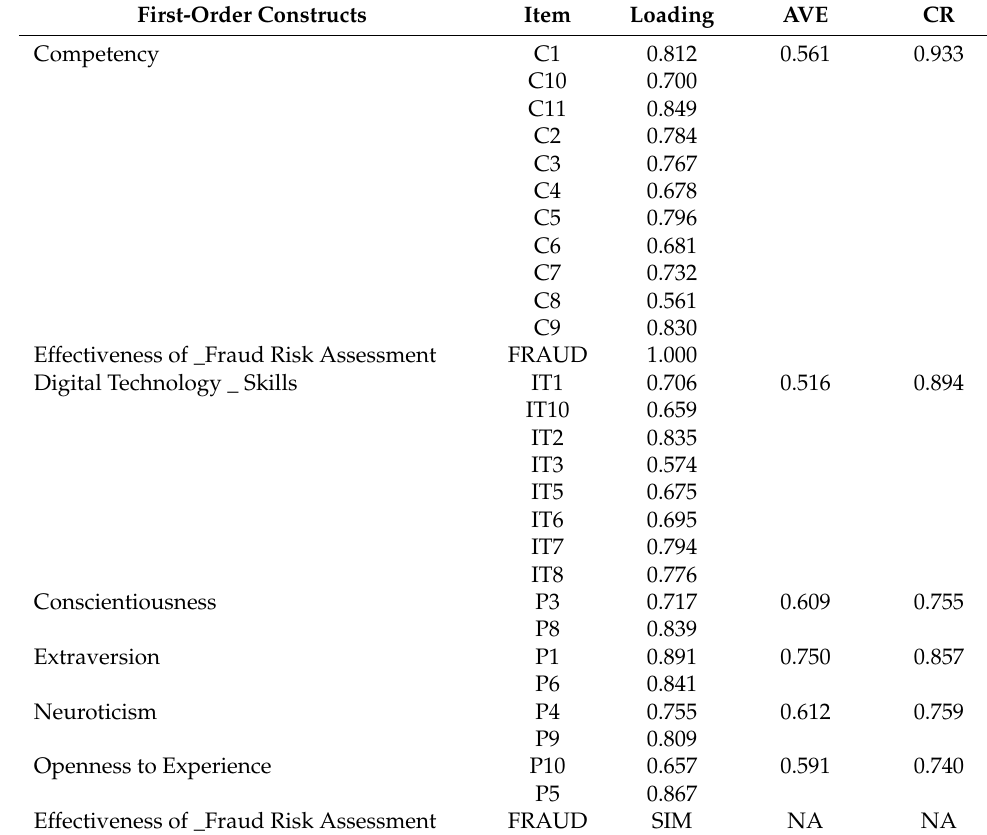
Table 3. Measurement Model for First-Order